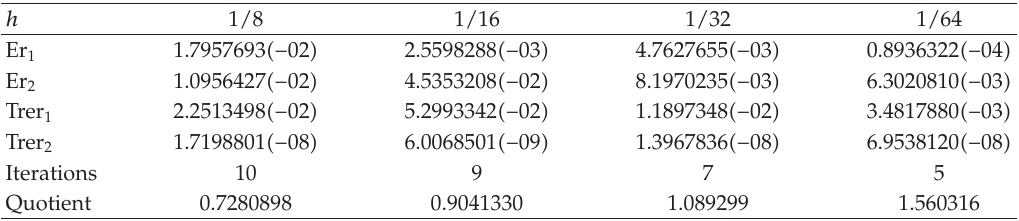
Table 3: Results on the square without a posteriori estimates as a stopping criteria for the second example.